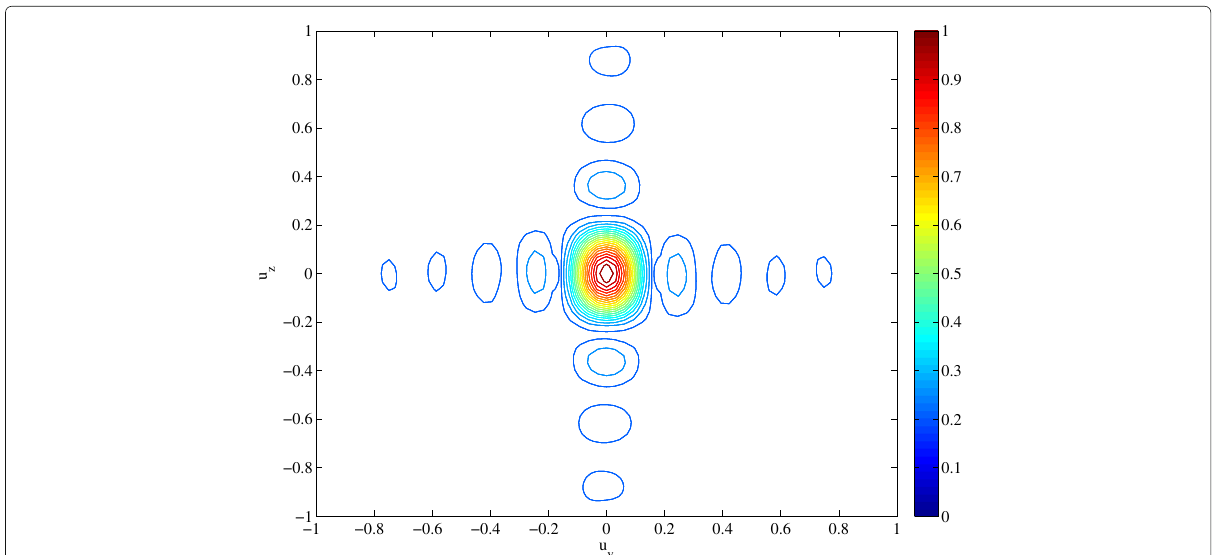
Fig. 7 Contour plot of magnitude of average beam pattern for random antenna selection with UPA : M = 16, K =